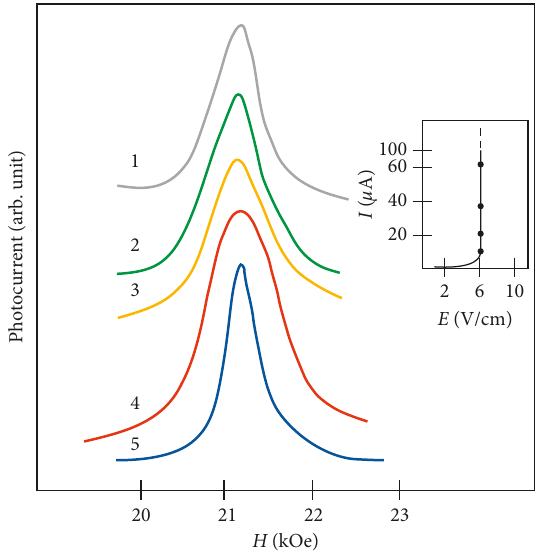
Figure 21: CR line shape measured in the constant current regime at ε ε BD and λ 337 μ m. The corresponding values of the current are shown in the inset of the CVC curve. The value of the current corresponding to the curve 5 is the same as that in the curve 4, but ≈ ≈ the radiation intensity is 7 times